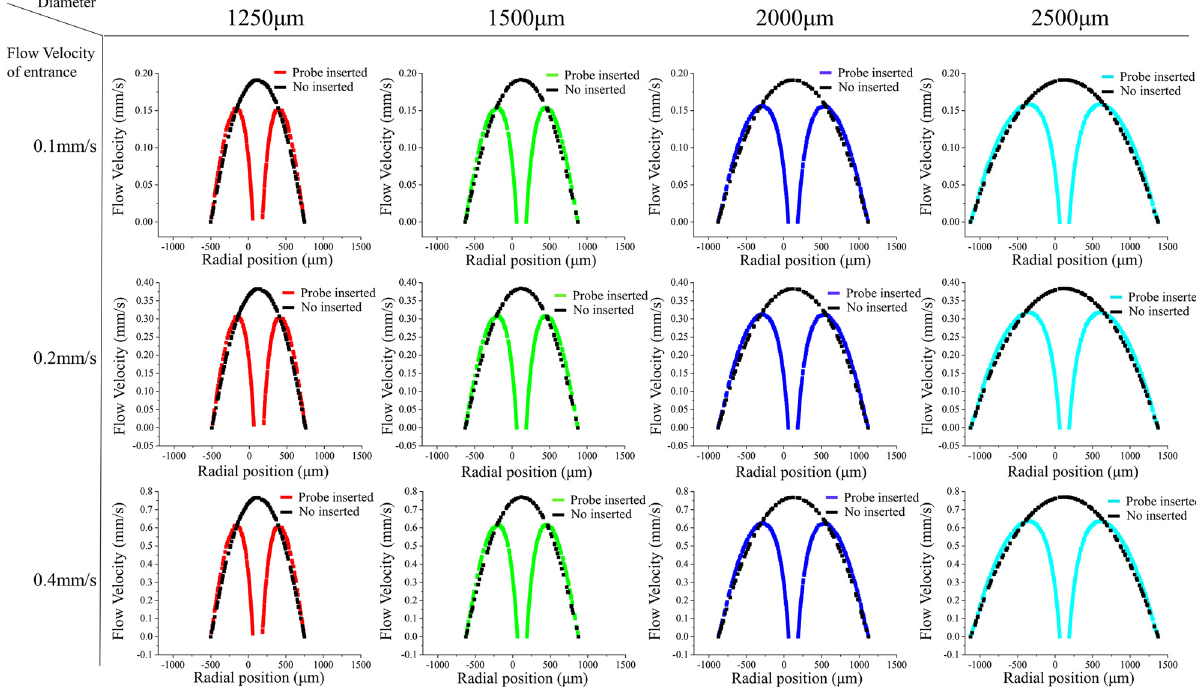
Figure 3: The effect of the insertion of the probe on actual flow velocity field in radial flow layer in channels with different diameter.